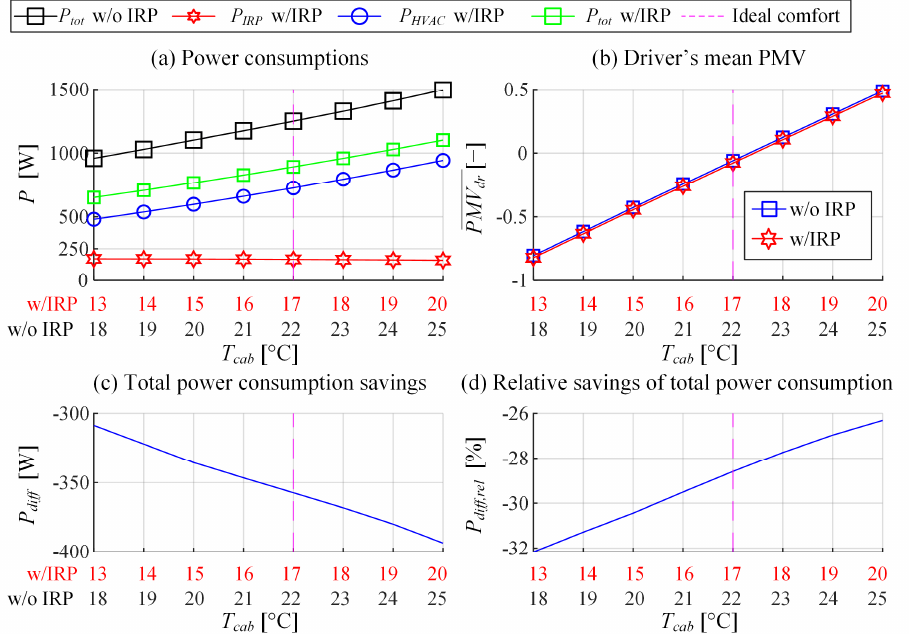
Figure 11. Simulation results of HVAC-only and HVAC+IRP systems for scenario of constant cabin air temperature target difference of 5 °C.